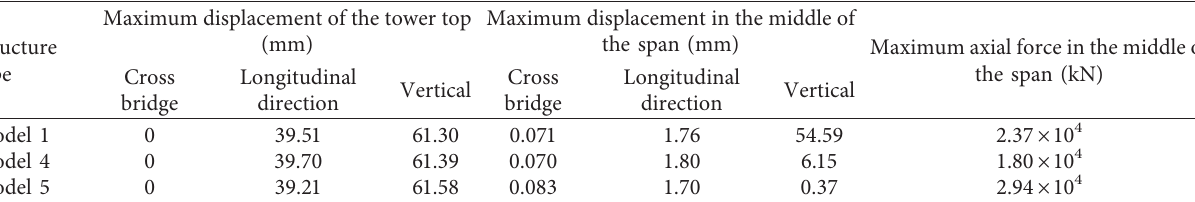
Table 11: Displacements and axial forces of the three structural models under longitudinal bridge excitation. Structure